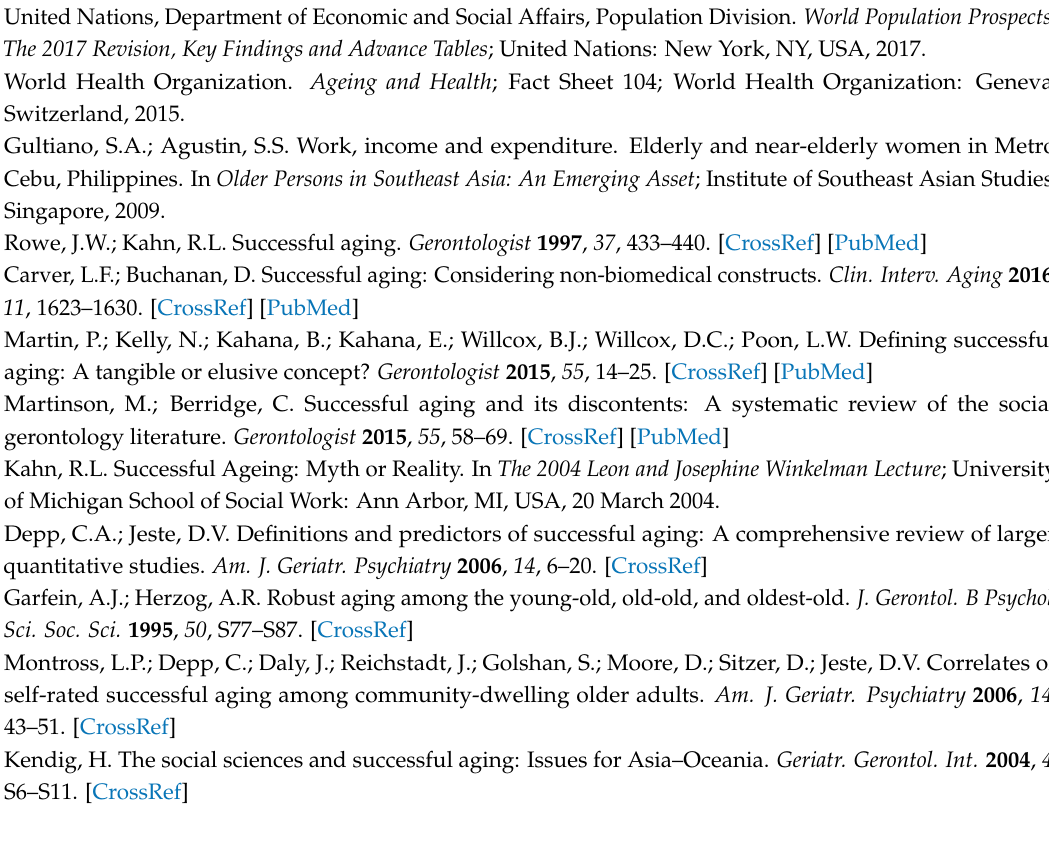
Table S1: Age-stratified univariate associations of sociodemographic and behavioral determinants of SA, Table S2: Age-stratified multivariable associations of sociodemographic and behavioral determinants of SA. Author Contributions: Conceptualization, E.T. and L.S.A.; methodology, E.T., L.S.A.; formal analysis,